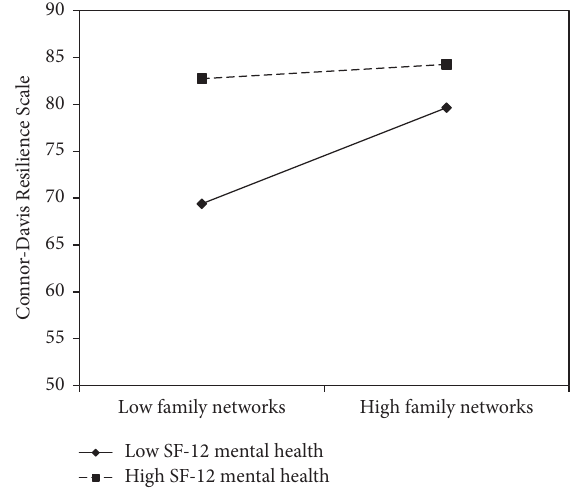
Figure1:ThesimpleslopesofLubbenSocialNetworkScale-6family networks on Connor-Davis Resilience Scale scores at high and low levels of SF-12 Mental Health Component Summary